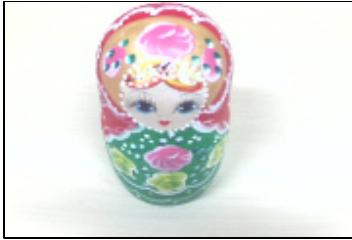
Figure 11. Target object.